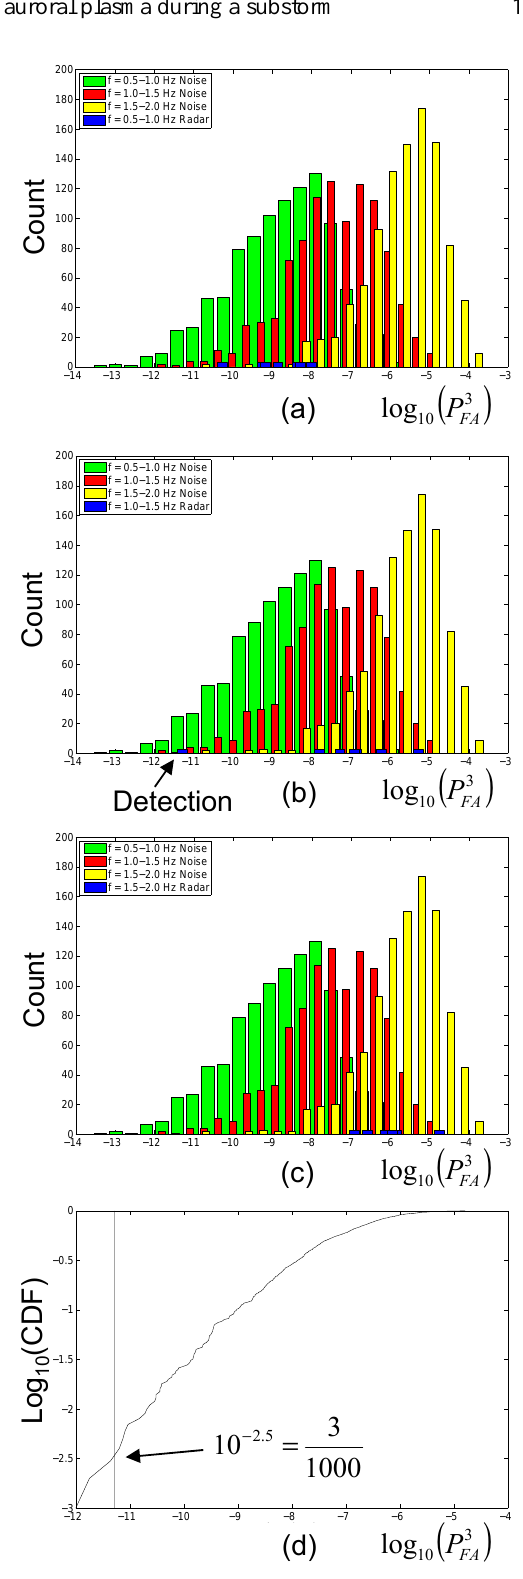
Fig. 5. Histograms of noise for three frequency ranges, with data points for the 5 beams in blue, along with the CDF for panel (b): (a) 0.5–1.0Hz, (b) 1.0–1.5Hz, (c) 0.5–1.0Hz, (d) CDF with verti- cal line indicating the